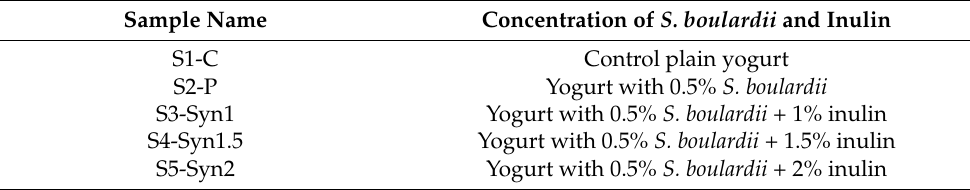
Table 1. Experimental groups of yogurt